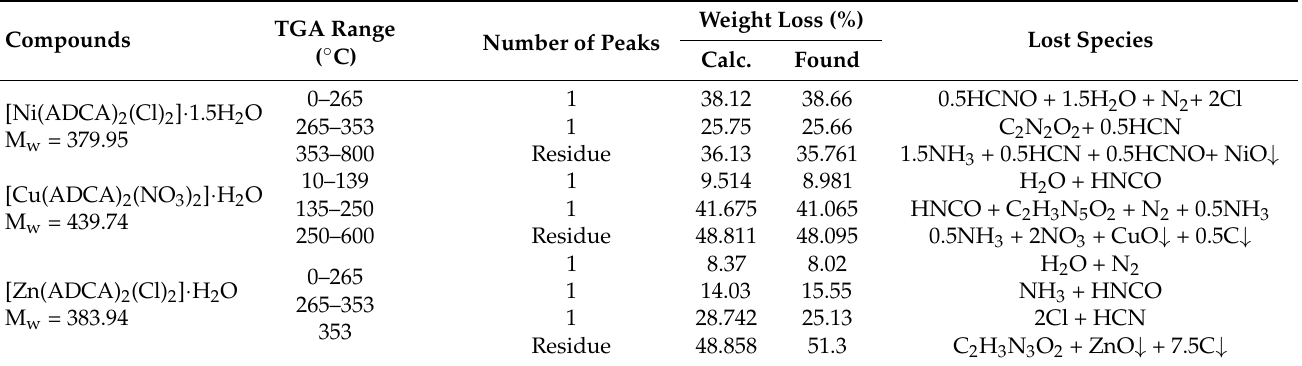
Table 3. The maximum temperature, T max ( ◦ C), and weight loss values of the decomposition stages for azodicarbonamide metal